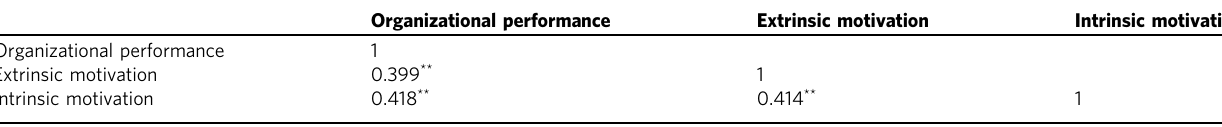
Table 4 Correlation